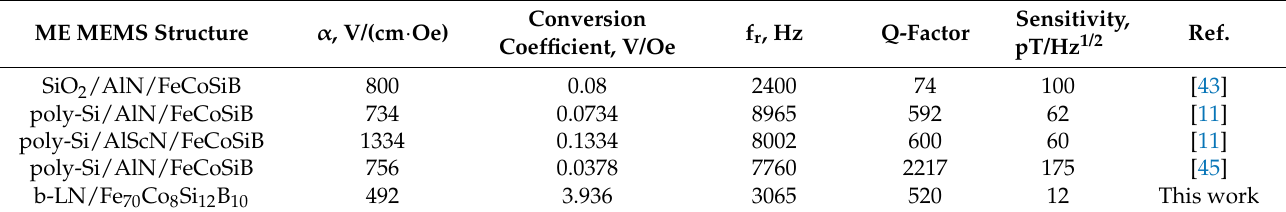
Table 2. Comparison of lead-free ME MEMS